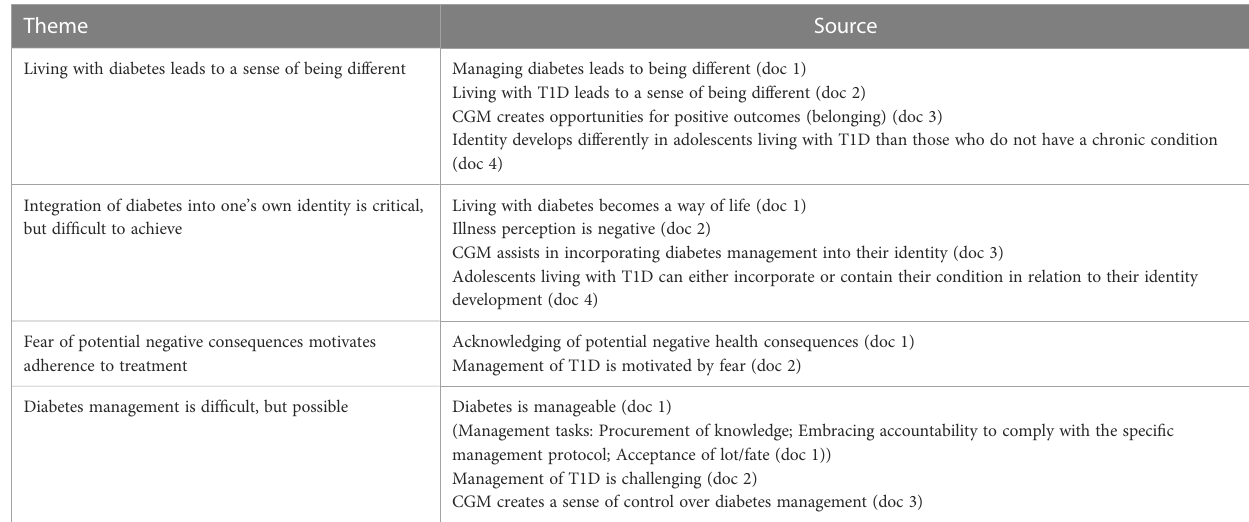
TABLE 1 Summary of